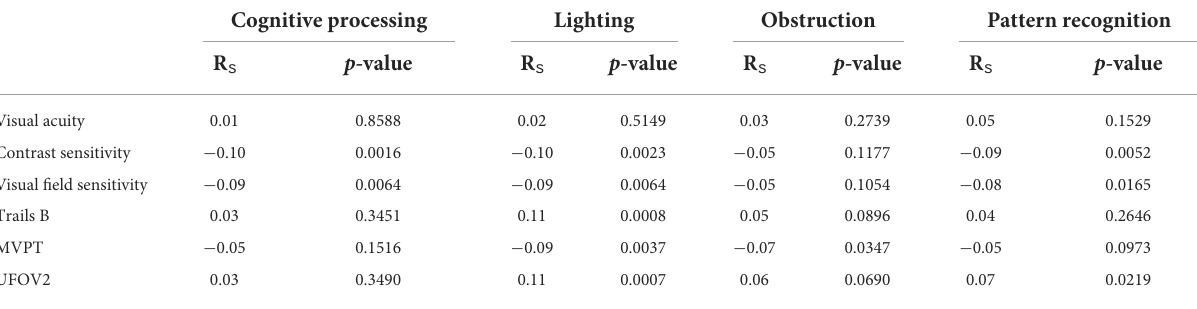
TABLE 4 Associations of person abilities of dashboard ergonomic domains with visual functions, adjusted for age and gender. Cognitive processing